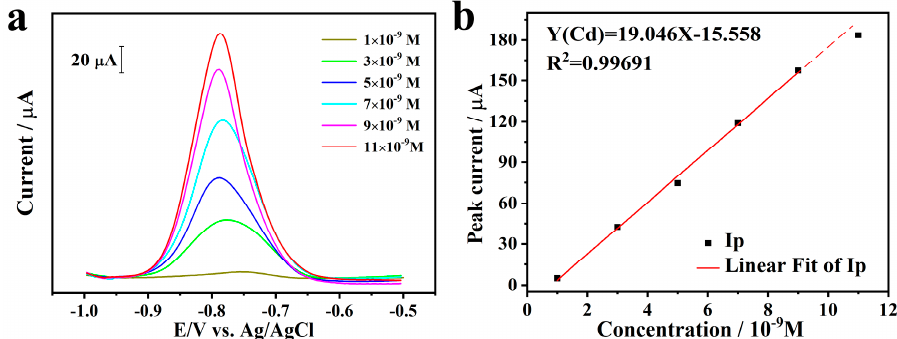
Figure 3. ( a ) SWASV of Bi@PG in 0.2 M (pH = 5.0) acetic acid buffer solution with gradient concentration of Cd 2+ ; ( b ) The corresponding linear calibration plots of peak currents vs. concentrations of Cd 2+ .